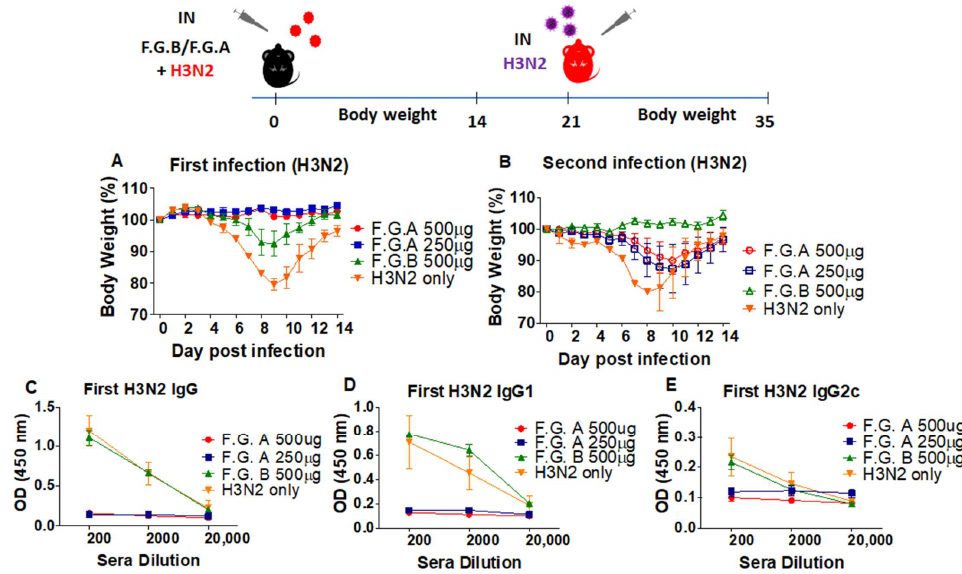
Figure 3. Fermented ginseng sample A showed higher antiviral protective activity against 1.0 LD 50 H3N2 influenza viruses. Groups of mice ( n = 5, CD8 T cell-deficient, CD8KO) were intranasally (IN) infected with a mixture of 1 LD 50 of A/Philippines/82 (H3N2) virus and fermented ginseng sample A or B at different doses (250 and 500 µ g). After 14 days of body weight monitoring, the serum sample was collected to detect the levels of IgG and IgG isotypes after the first infection using an ELISA method. The mice that survived from H3N2 virus infection were challenged with homogenous virus (1.5 LD 50 , H3N2). ( A ) Body weight change after the first infection (H3N2) and ( B ) body weight change after the second infection (H3N2). ( C ) H3N2 specific IgG, ( D ) IgG1, and ( E ) IgG2c after the first infection. F.G.A: H3N2 virus + fermented ginseng sample A; F.G.B: H3N2 virus + fermented ginseng sample B; H3N2 only: virus infection without ginseng samples.